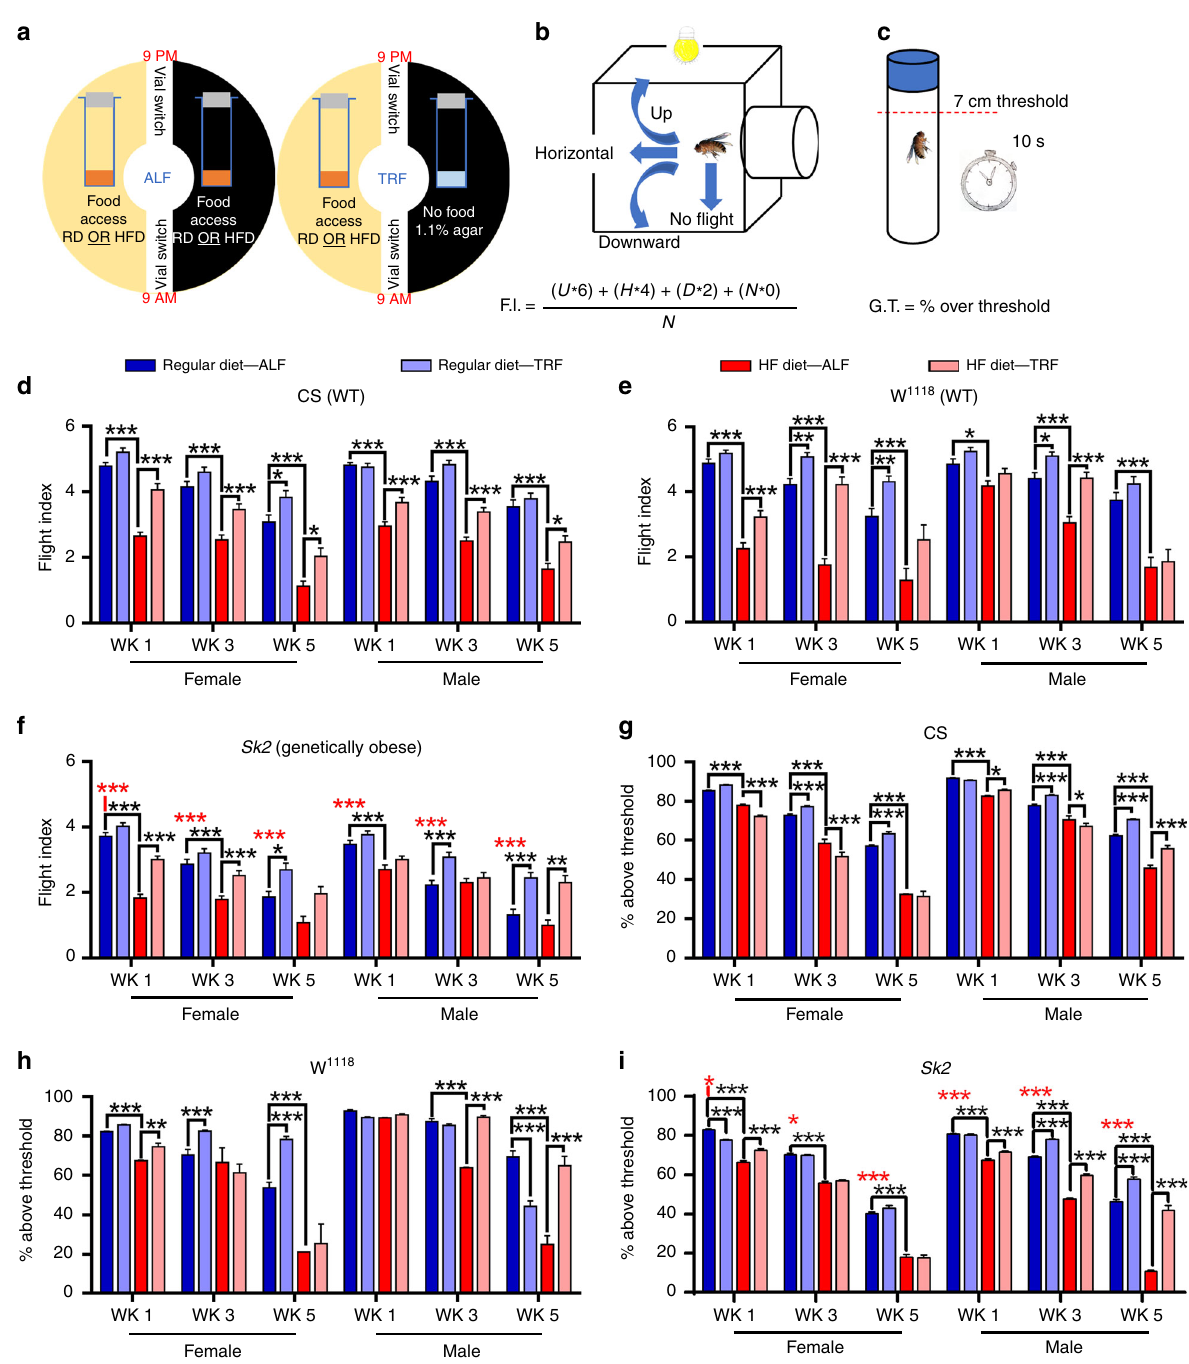
Fig. 5 Time-restricted feeding attenuates age-related and obesity-induced dysfunction in the skeletal muscle. a Time-restricted feeding regimen. Wild-type and Sk2 mutant fl ies were placed in either of two feeding regimens, ALF or TRF, and either RD or HFD (see Fig. 1a). ALF fl ies had unrestricted access to food throughout the day compared to TRF fl ies which were only allowed to eat during the fi rst 12 h and were transferred to 1.1% agar during the